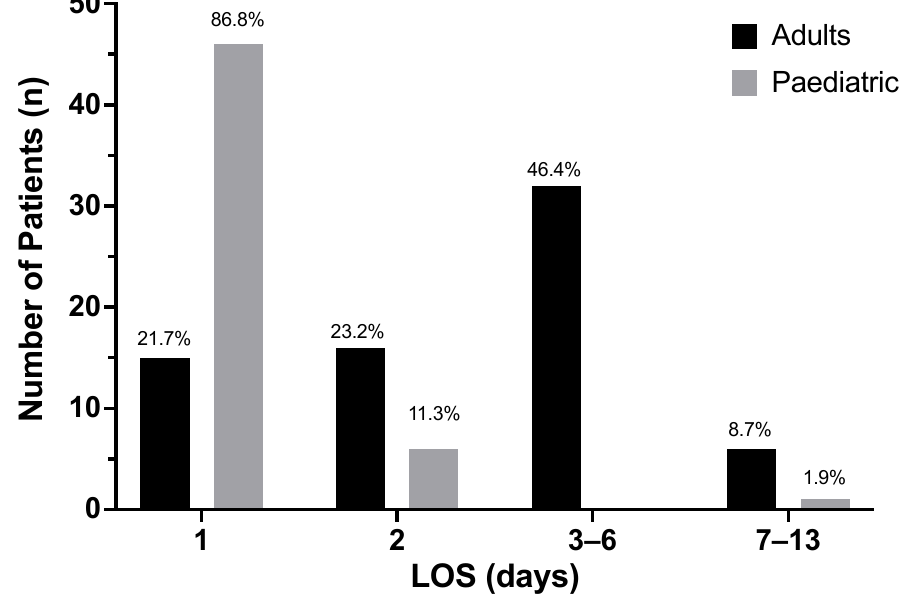
Figure 3. Length of Stay (LOS) in days of adult and paediatric patients admitted with sunburn injuries to the Manchester burn centres between 2010–2019 (inclusive).